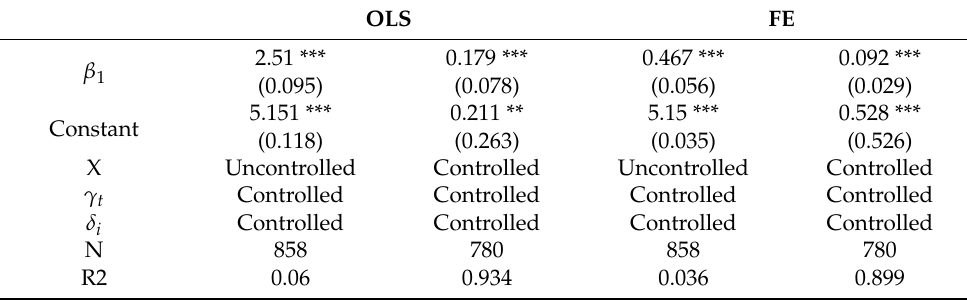
Table 1. The CFFP’s impact on the cattle industy’s production in Weichang County (DID). OLS FE β